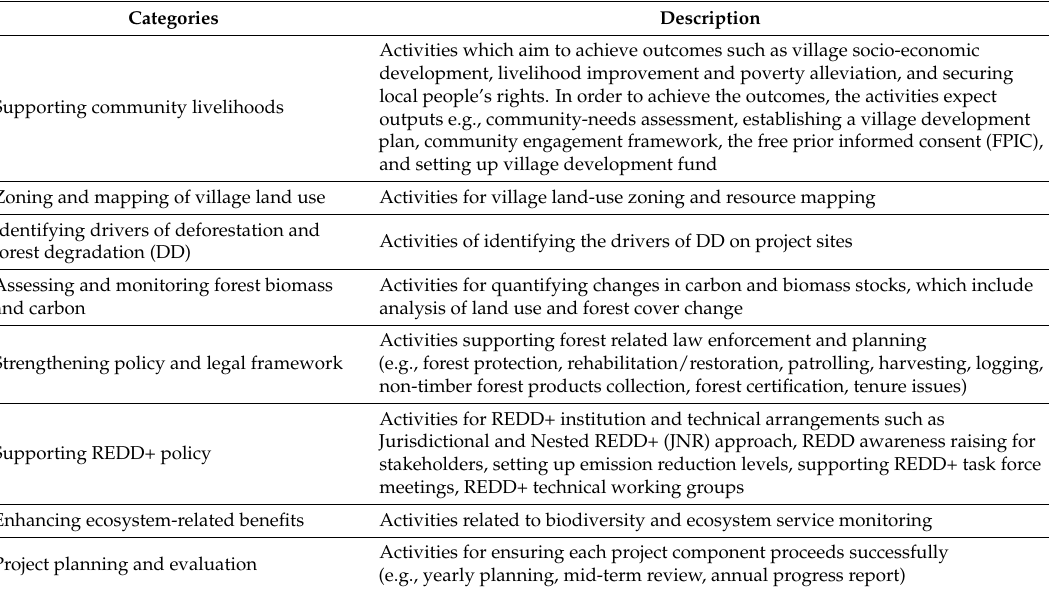
Table 3. Categorization of selected project activities.